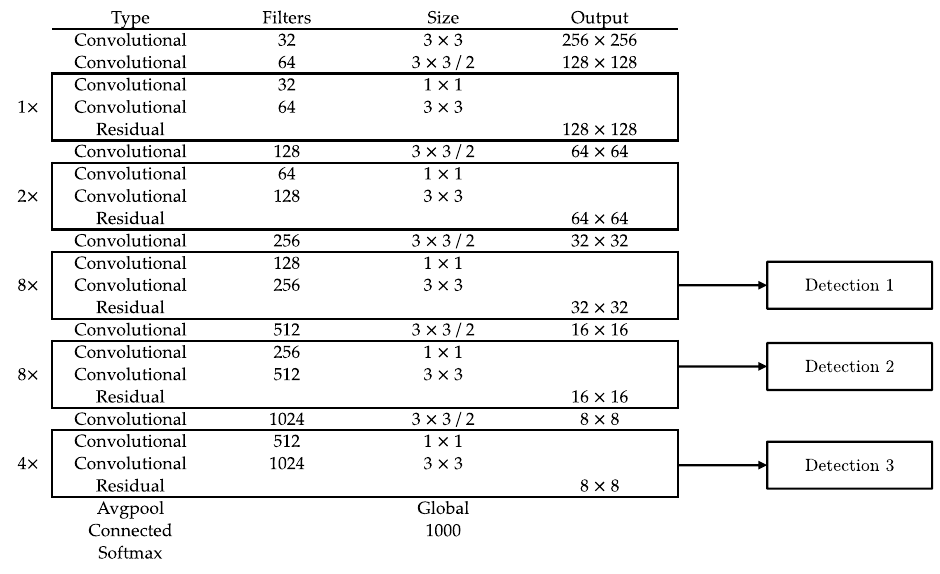
Figure 5. Architecture of Darknet53.